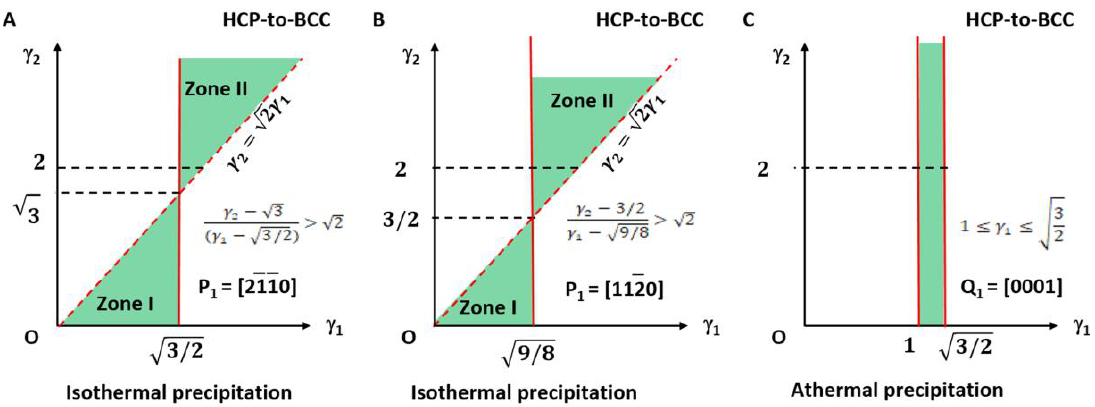
Figure 5. Lattice parameter applicable range (green colour) for HCP-to-BCC transformation of isothermal ( A , B ) and athermal ( C ) precipitation. ( A ) Triangular zones I and II for isothermal type I. ( B ) Triangular zones I and II for isothermal type II. Dashed line indicates forbidden line. ( C ) Rectangle zone of athermal type.